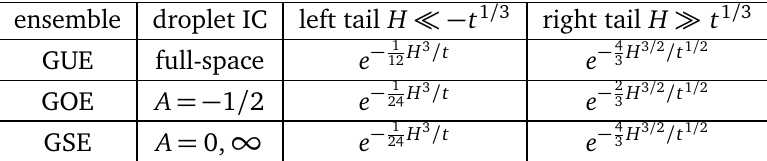
Table 1: Tails of the PDF of the centered height H for large time t (cid:29) 1 in the typical fluctuation regime H ∼ t 1 / 3 in the various